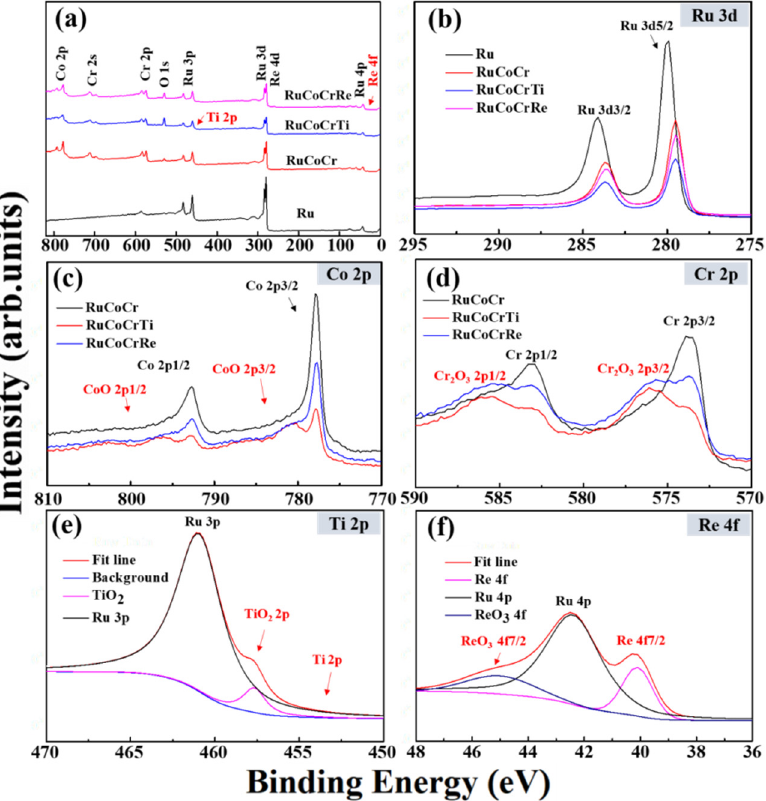
Figure 5. X-ray photoelectron spectroscopy (XPS) spectra of intermediate layers, ( a ) full spectra, ( b ) Ru, ( c ) Co, ( d ) Cr, ( e ) Ti, ( f ) Re.